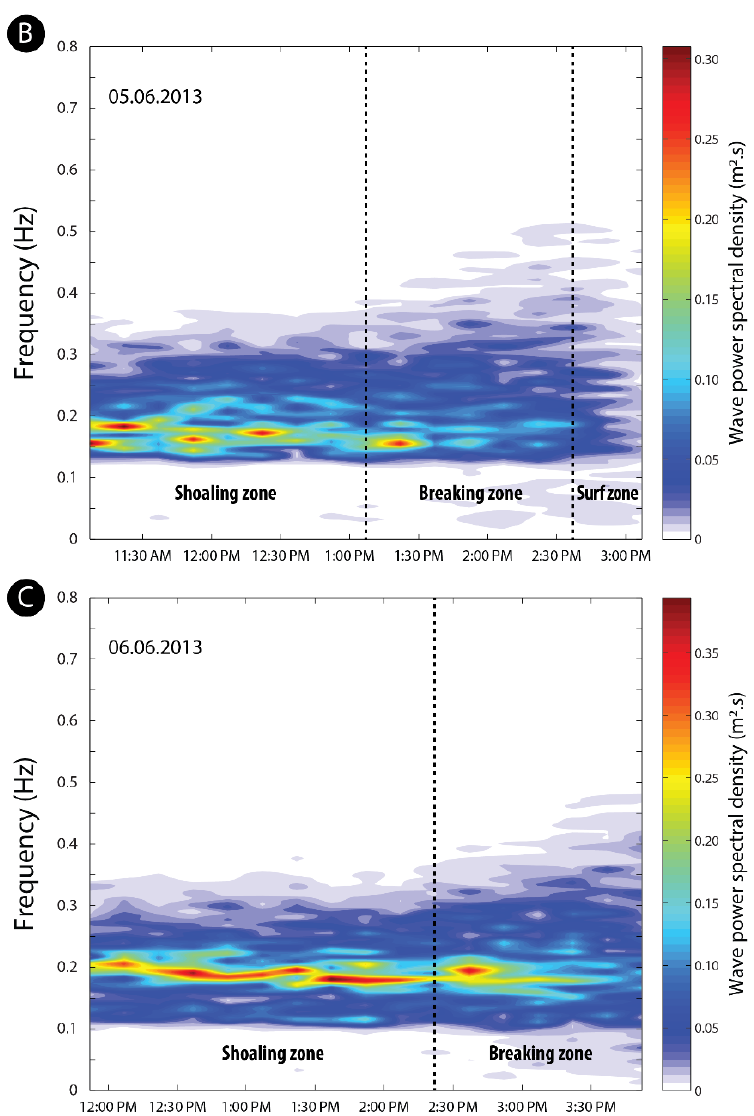
Figure 8. Temporal variations in wave frequency and wave power spectral density over bar B3 (see Figure 2D for location) under non-breaking and breaking wave processes as water depth decreased during falling tide during moderate energy conditions (offshore H s ≈ 1.2 m) on ( A ) 4 June (high tide at 10:30 AM and low tide at 05:30 PM) and ( B ) 5 June 2013 (high tide at 11:30 AM and low tide at 06:30 PM), and during higher energy conditions (offshore H s ≈ 1.4–1.5 m) on ( C ) 6 June 2013 (high tide at 12:15 AM and low tide at 19:15